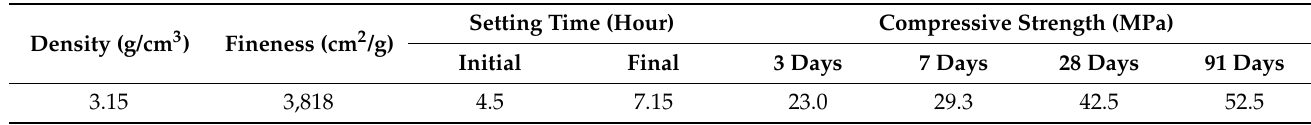
Table 3. Physical properties of the